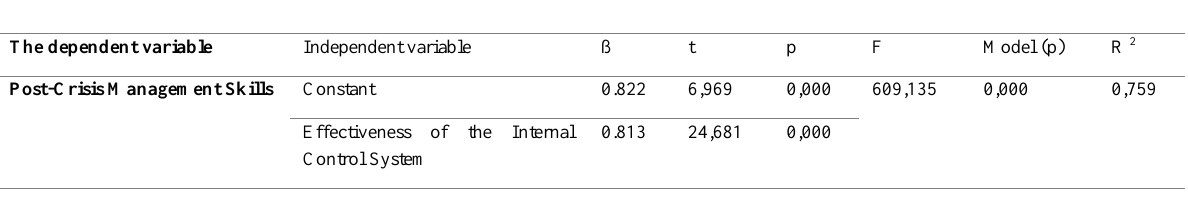
Table 7: The Effect of the Efficiency of Internal Control System on Post-Crisis Management Skills